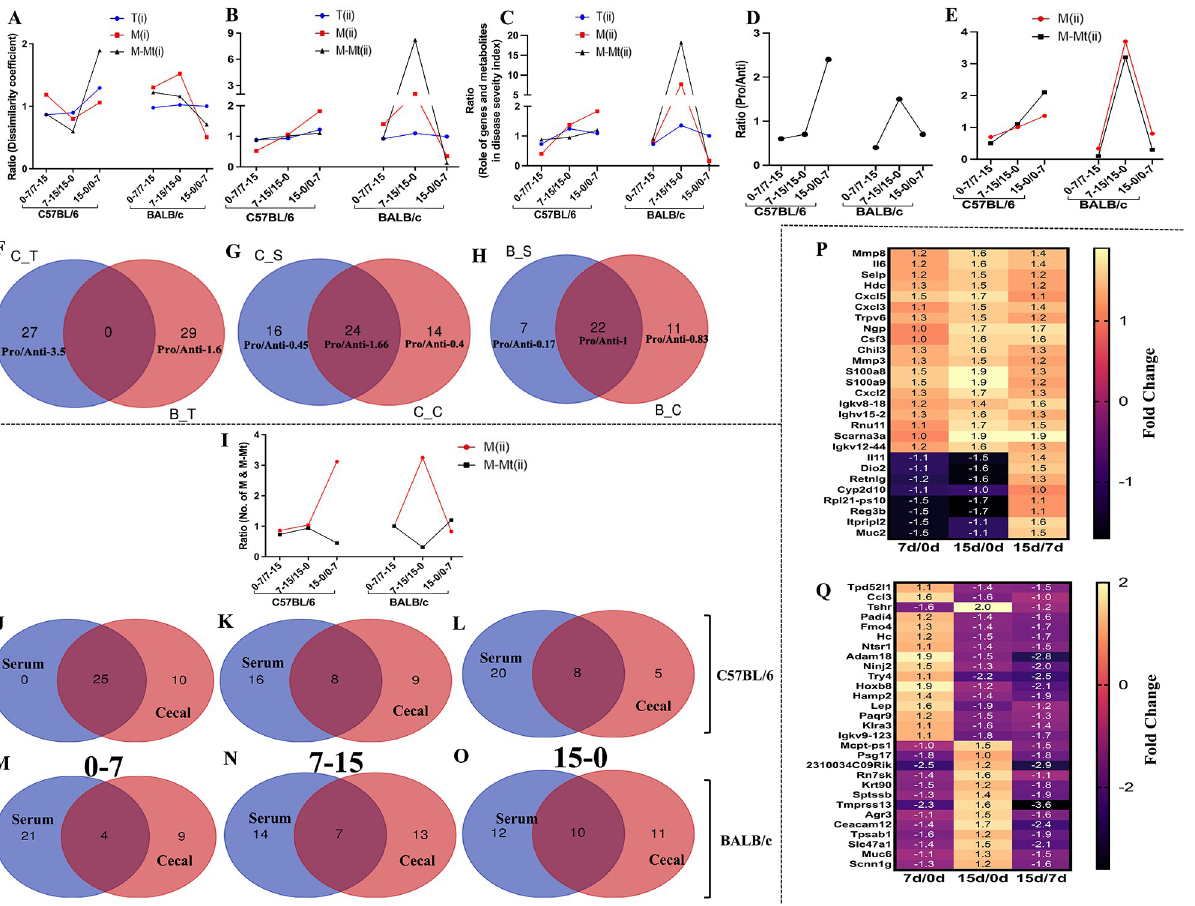
Fig 3. Detailed analysis of altered transcriptomics and metabolomics status of the host at different stages of the disease. From LDA, we have found that both mice strain formed three distinct clusters based on different treatment conditions. We have clustered the mice based on altered genes (T), metabolites (M), and meta-metabolites (M-Mt) expressions and measured the distances between different clusters on the 2D plane to quantify the difference between the treatment conditions. Every other bunch signifies a different treatment condition. We have measured the distance (dissimilarity coefficient) ratio of varying treatment conditions (clusters) to observe the kinetics of altered genes, metabolites, and meta-metabolites expressions at various treatment conditions for both the strains of mice. Panel (A) depicted the ratio of distances of different clusters when we considered all (i) the altered genes, metabolites, and meta-metabolites expressions for LDA analysis. Panel (B) depicted the ratio of distances of different clusters when we considered only the significantly (ii) altered genes, metabolites, and meta-metabolites expressions for LDA analysis. Further, we assess the influence of genetic and metabolic factors in determining the disease severity index (Panel C). We have quantified the ratio of pro and anti-inflammatory genes (Panel D) metabolites and meta-metabolites (Panel E) in different treatment conditions for C57BL/6 and BALB/c to know the role of inflammation in the determination of differential disease outcomes. We have also found that significantly altered genes were very much strain-specific (Panel F), and in C57BL/6 (C_T), the altered genes mainly were pro-inflammatory. In BALB/c (B_T), the altered genes were mostly related to anti-inflammation. To quantify the contributions of host metabolism and gut microbial metabolism in the inflammatory process, we calculated the ratio of significantly altered pro and anti-inflammatory metabolites from serum (S) and cecal content (C) of C57BL/6 (C) and BALB/c (B) mice. We found that in C57BL/6, host and microbial metabolites both triggered the inflammatory condition of the host (Panel G). On the contrary, in BALB/c, gut microbial metabolites contribute more to trigger the inflammatory condition of the host (Panel H). To investigate how the diversity of serum and cecal metabolites altered with altered inflammatory conditions, we calculated the ratio of no. of metabolites and meta-metabolites in different disease severity for both strains (Panel I). We also assessed how the no. of significantly altered common and unique metabolites from serum and cecal content changed along with the different treatment and disease severity levels in C57BL/6 (Panel J, K, L) BALB/c (Panel M, N, O) mice. The shortlisted genes from transcriptomics analysis responsible for differential disease progression in C57BL/6 (Panel P) and BALB/c (Panel Q) mice were depicted as the heat map in panels P and Q. Fold changes of the gene expressions were presented as a heatmap.